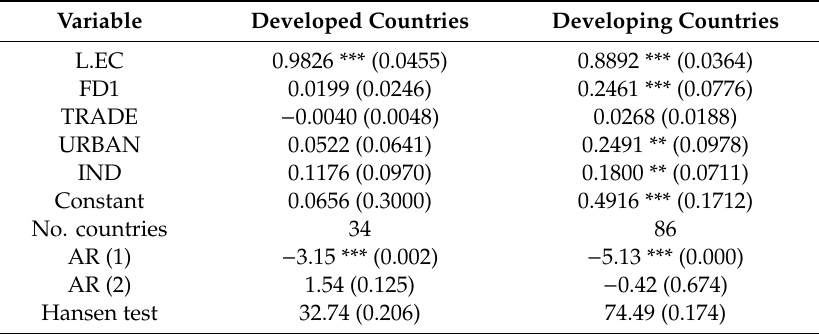
Table 8. Results of sub-sample regressions.